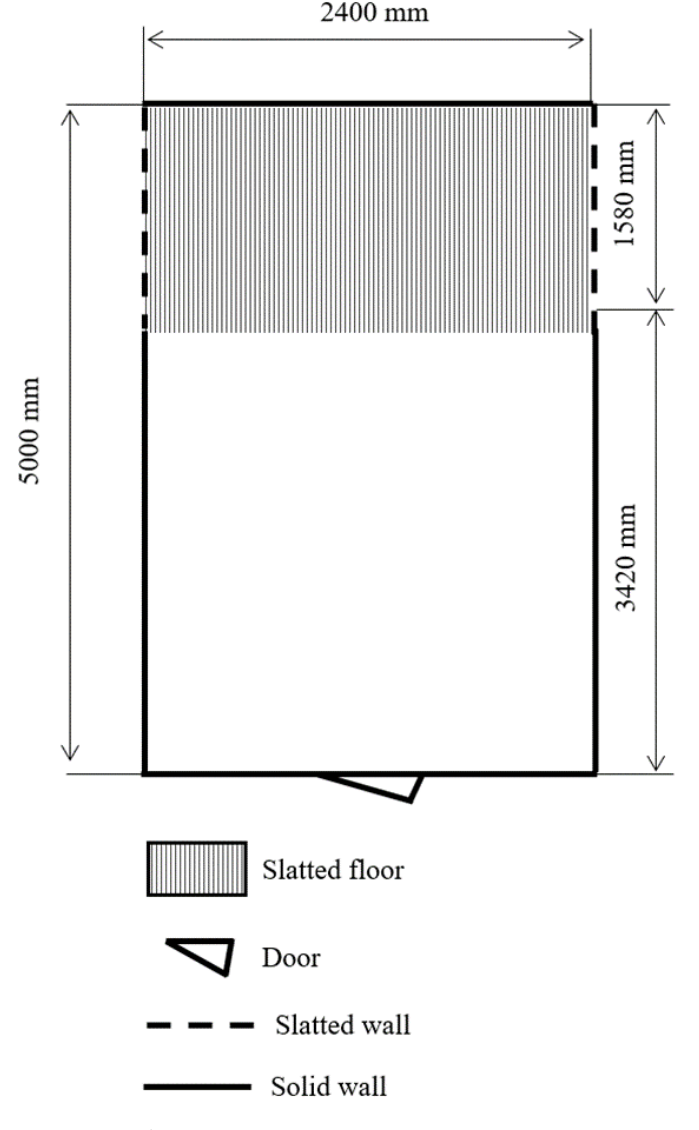
Figure 1. Pen layout.